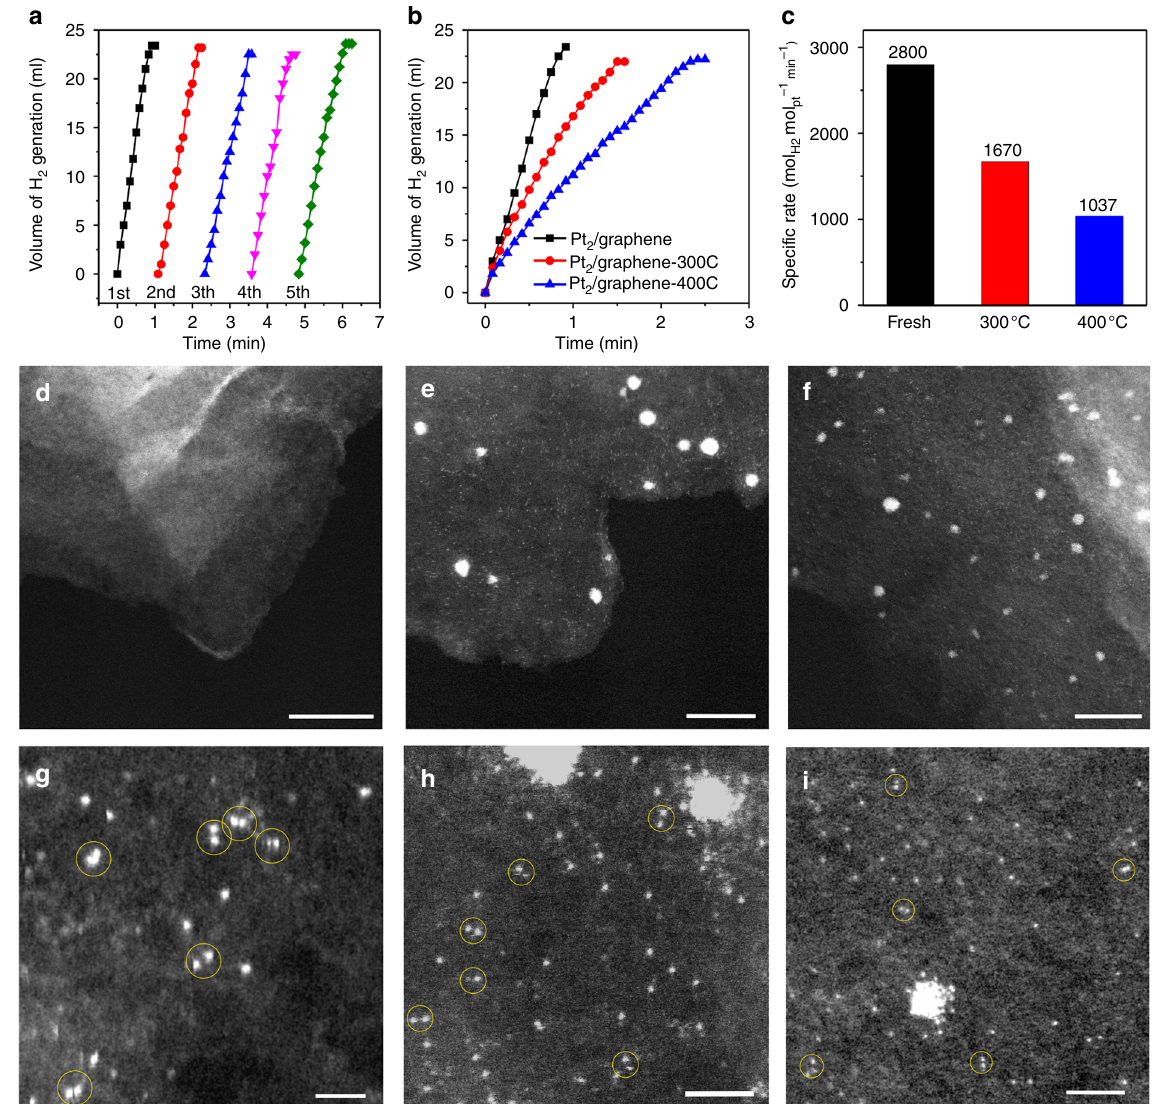
Fig. 6 Stability of the dimeric Pt 2 /graphene catalyst. a Five recycles in hydrolytic dehydrogenation of AB at room temperature over the dimeric Pt 2 / graphene catalyst by adding additional 0.325 mmol of pure AB into the reaction fl ask after each run. b Plots of time vs volume of hydrogen gas generated from AB hydrolysis and c the corresponding speci fi c rates at room temperature over the dimeric Pt 2 /graphene catalysts after different pretreatments: